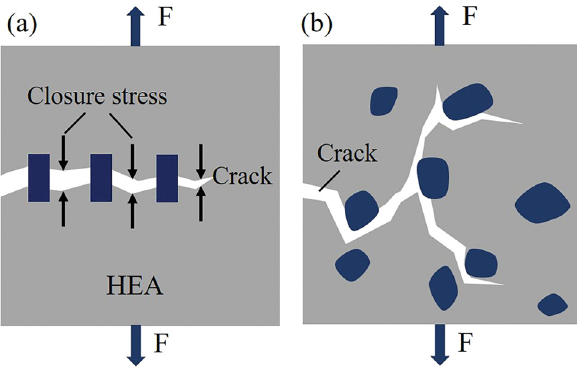
Figure 11: Schematic diagram of ( a ) crack bridging and ( b ) crack de fl ection mechanisms.